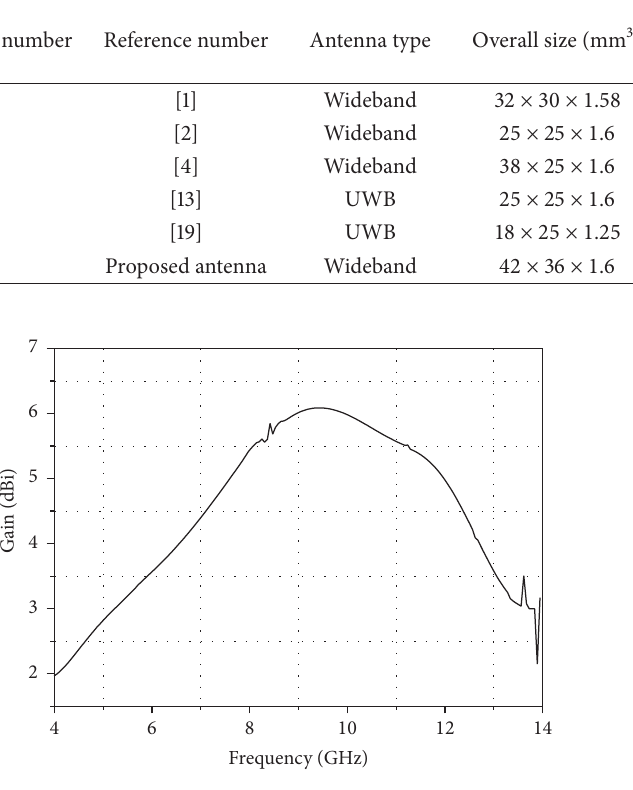
Figure 18: Radiation efficiency for the proposed defected substrate wideband